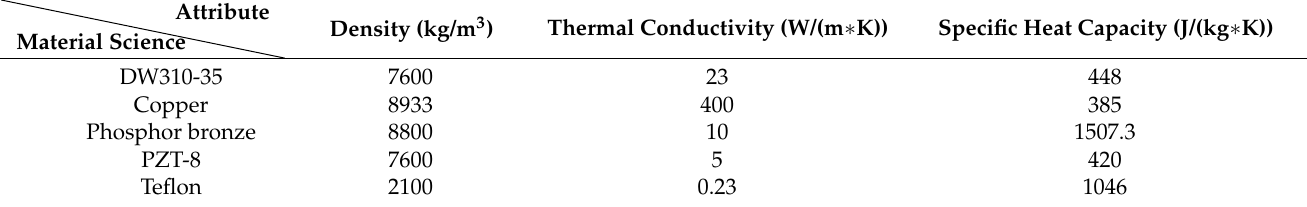
Table 5. Material